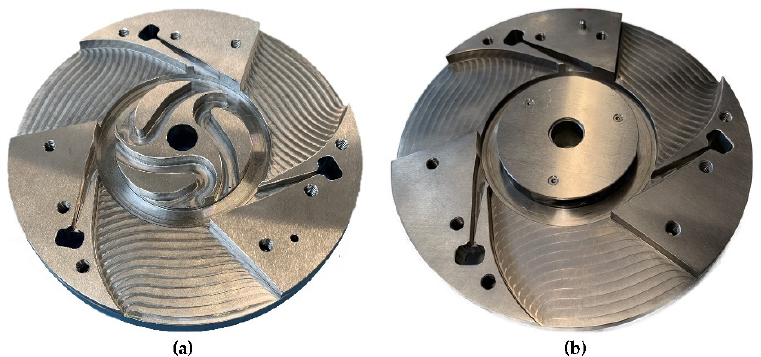
Figure 9. Stator of the Elektra turbine: ( a ) without deflection channel cover ( Version 1 ); ( b ) with applied channel cover ( Version 2a ).